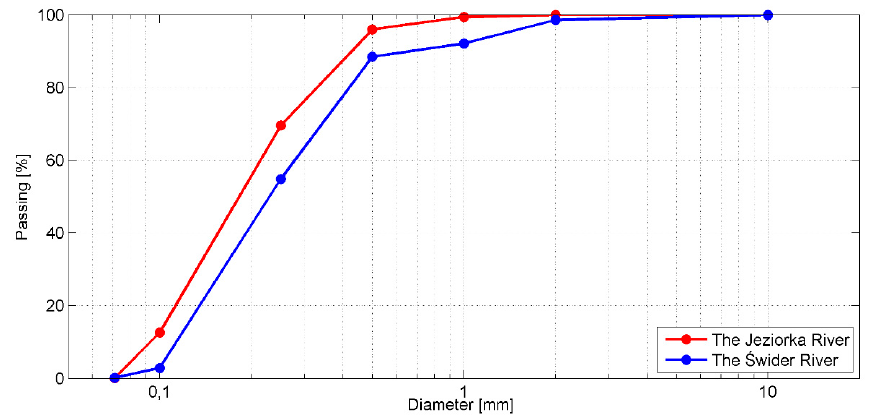
Figure 1. Granulometric distribution curves of bed sediment collected from the Jeziorka and Ś wider Rivers.